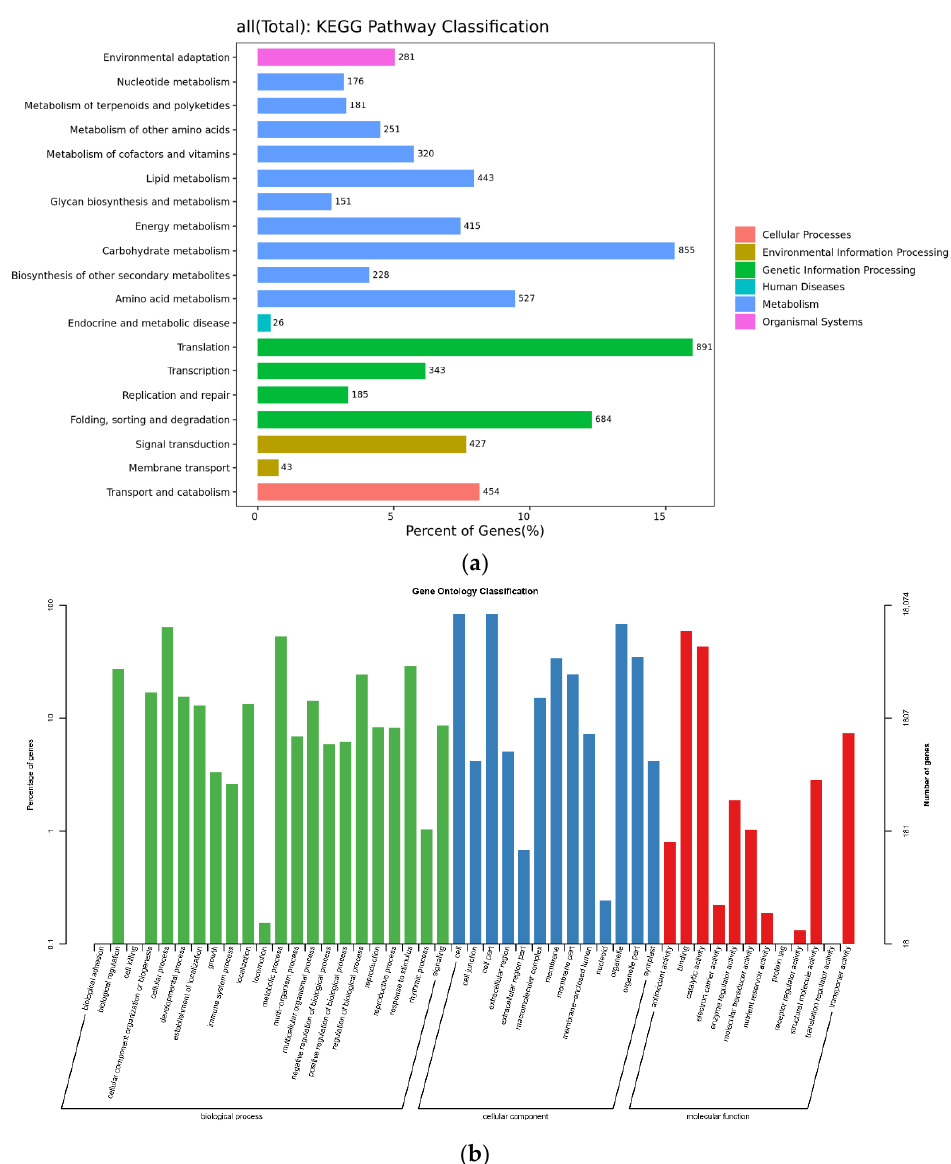
Figure 3. Annotation of unigenes in KEGG and GO datasets. ( a ) KEGGs. The horizontal axis repre- sents the percent of genes annotated to the pathway; the vertical axis represents the Level 2 pathway name, and the number on the right of the bar represents the number of genes annotated to this Level 2 pathway. ( b ) GO. The horizontal axis represents the GO functional classification; the left vertical axis represents the percentage of genes annotated to that class, and the right vertical axis represents the number of genes annotated to that class.